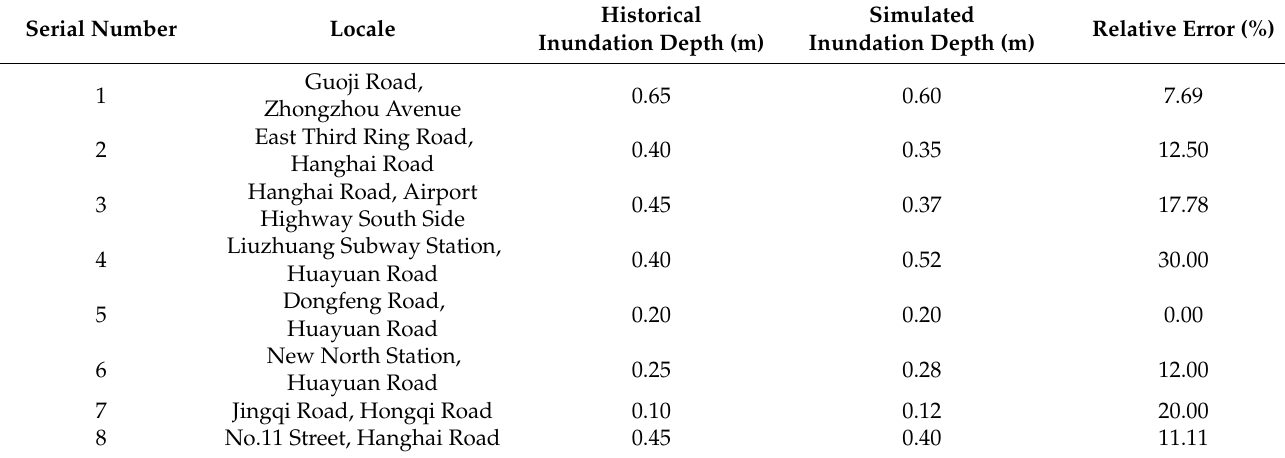
Table 3. Calibration results of rainfall event A.